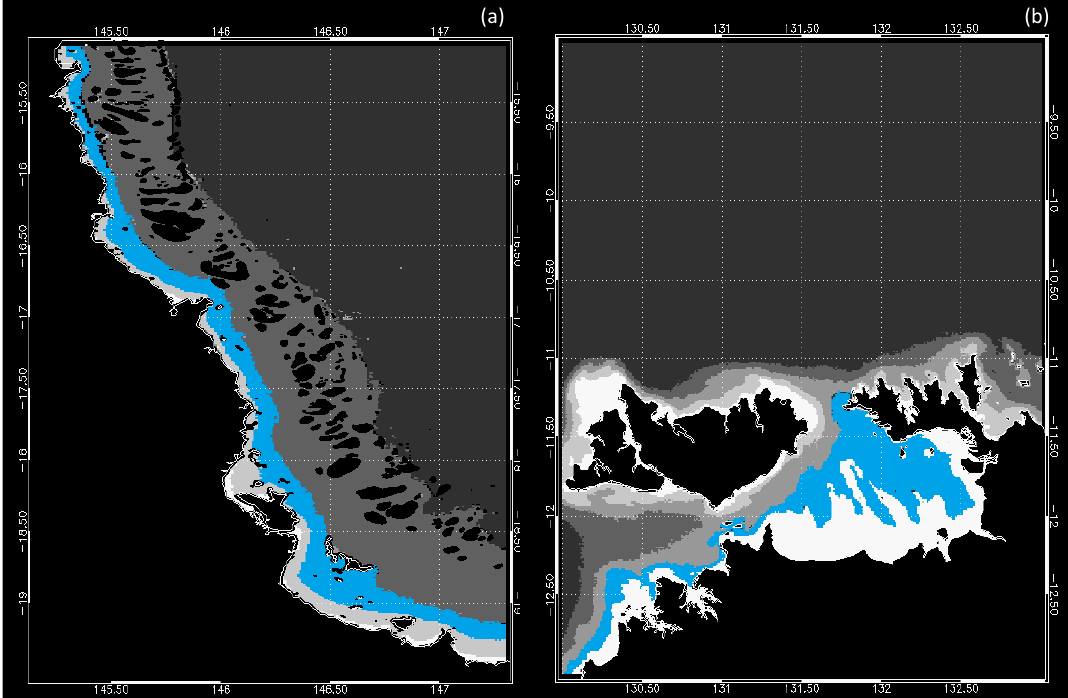
Figure 5. K-means Chl clustering results for ( a ) the GBRW and ( b ) the VDG. Each cluster class (N = 5) is shown by a different color. The clusters selected for this study are shown in blue.